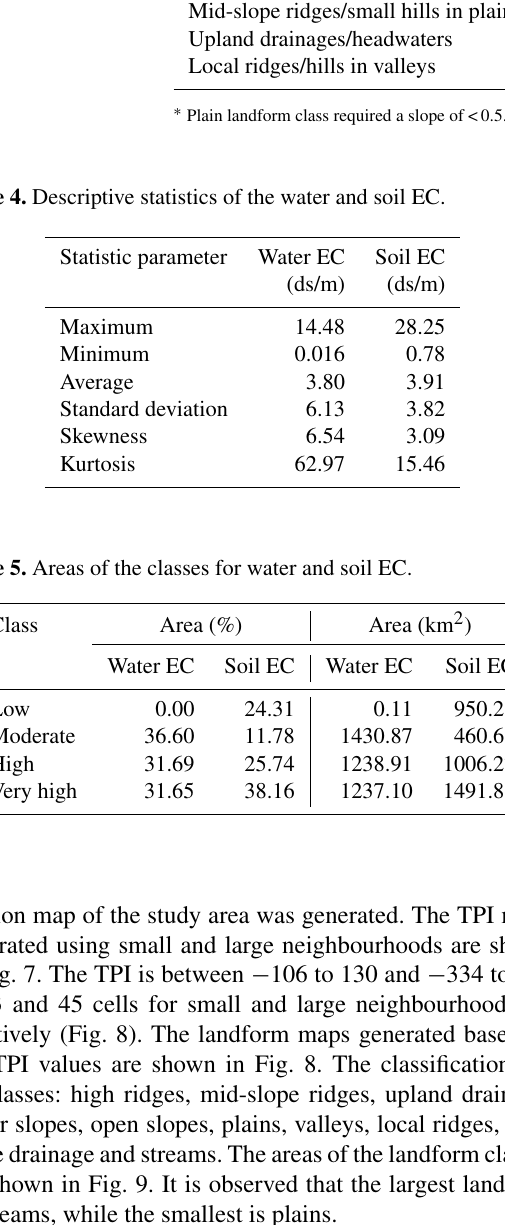
Table 3. Topographic Position Index (TPI) thresholds for small and large neighbourhoods used to define landscape feature classes. Landform TPI Small neighbourhood Large neighbourhood Plains − 1<TPI<1 − 1<TPI<1 ∗ Open slopes − 1<TPI<1 − 1<TPI<1 ∗∗ U-shaped valleys − 1<TPI<1 TPI< − 1 Mountain tops/high ridges TPI>1 TPI>1 Upper slopes/mesas − 1<TPI<1 TPI>1 Mid-slope drainages/shallow valleys TPI< − 1 − 1<TPI<1 Canyons/deeply incised streams TPI< − 1 TPI< − 1 Mid-slope ridges/small hills in plains TPI>1 − 1<TPI<1 Upland drainages/headwaters TPI< − 1 TPI>1 Local ridges/hills in valleys TPI>1 TPI< − 1